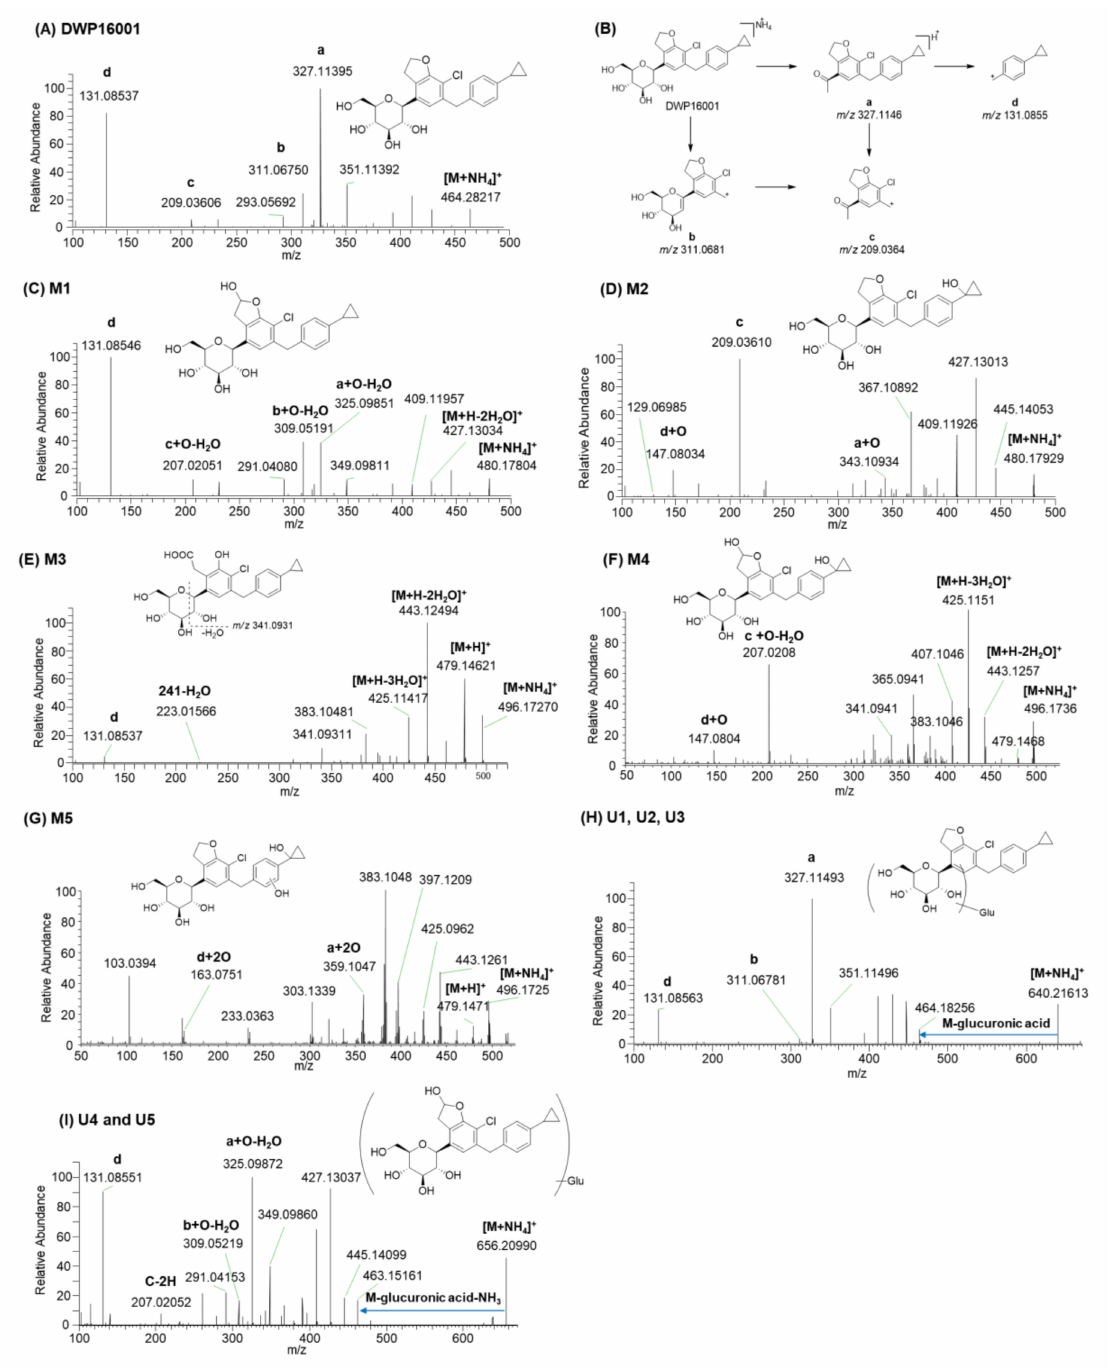
Figure 3. MS / MS spectra of ( A ) DWP16001 and ( C – I ) it’s possible metabolites and ( B ) the fragmentation mechanism of